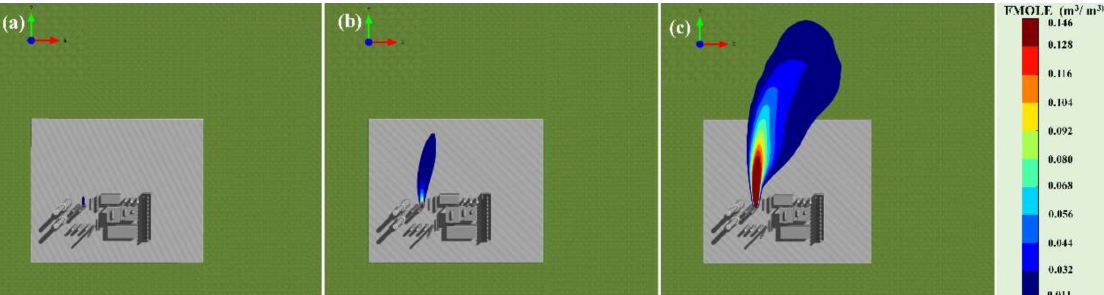
Figure 8. Cloud map of combustible gas volume fraction under different medium pressure. ( a ) Cloud map of 0.1 MPa medium pressure. ( b ) Cloud map of 1 MPa medium pressure. ( c ) Cloud map of 10 MPa medium